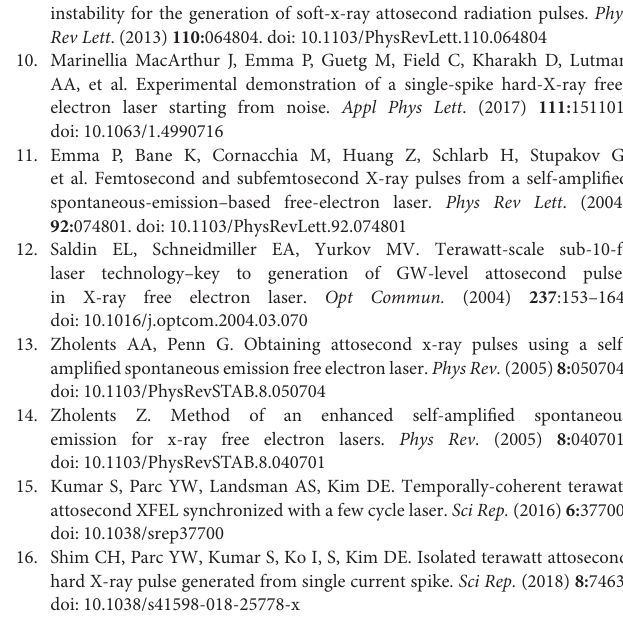
EUV pulse generation were investigated in detail by means of numerical simulations. The scaling of the generated attosecond EUV pulse energy with various parameters ( λ r , K RU ) was studied. For example, the nanobunches were predicted to emit 20-as EUV pulses at λ r = 5 nm with 10 nJ energy, 80-as EUV pulses at λ r = 20 nm with 90 nJ energy, and 240-as pulses at λ r = 60 nm with 200 nJ energy for K RU = 0.5. At longer generated wavelength or larger K generation of EUV pulses with more than 500 nJ energy can be possible. The shortening of the modulator laser pulse duration was discussed for the generation of isolated attosecond